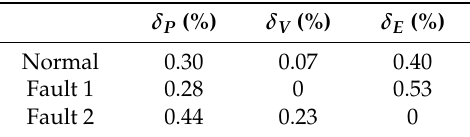
Table 2. Simulation errors in the transient